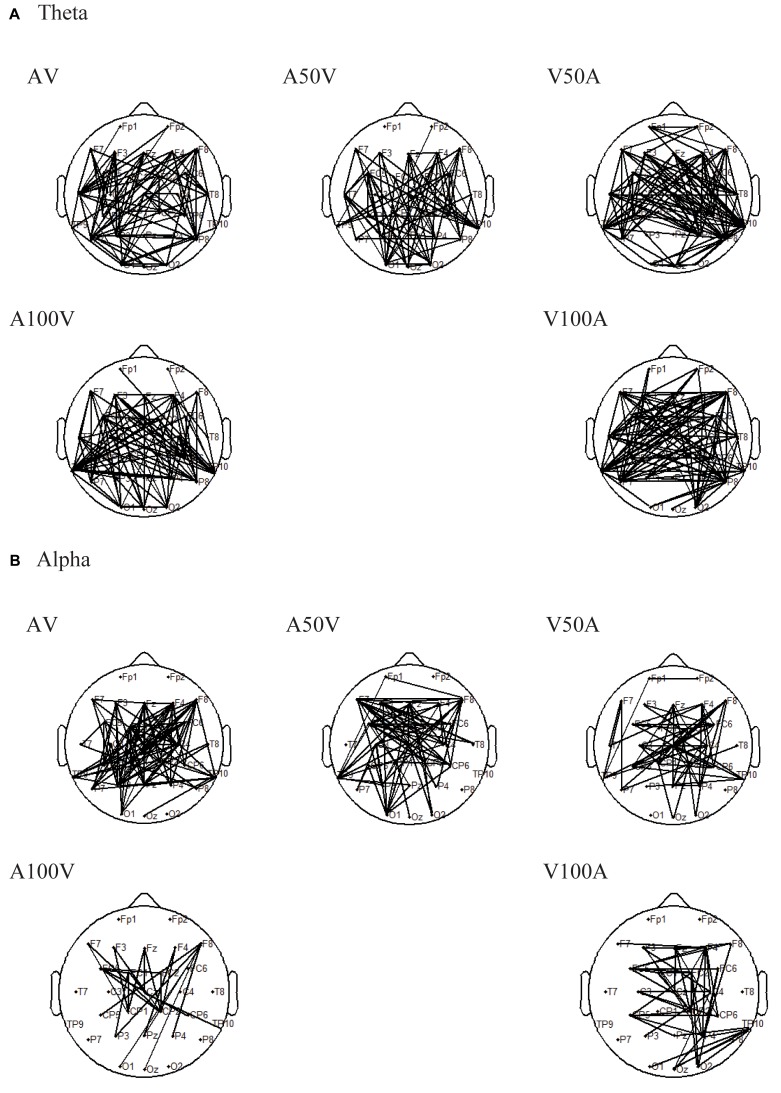
Results of pairwise associations. We used the NBS to identify interregional connectivity that significantly differed between the groups for the theta and alpha bands. (A) In the theta band, old adults had significantly stronger connections in all of the audiovisual conditions. (B) In the alpha band, old adults had significantly stronger connections in all of the audiovisual conditions.